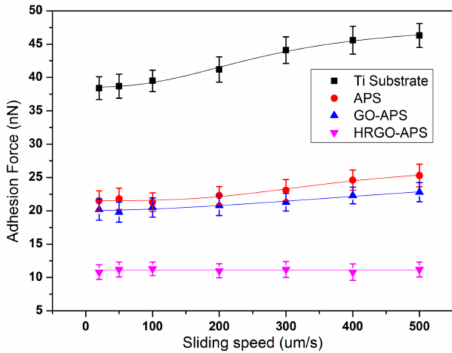
Figure 12. Variation of the adhesion force of Ti substrate and prepared coatings with the change of sliding speed (applied load: 100 nN, Scan area: 2 µ m × 2 µ